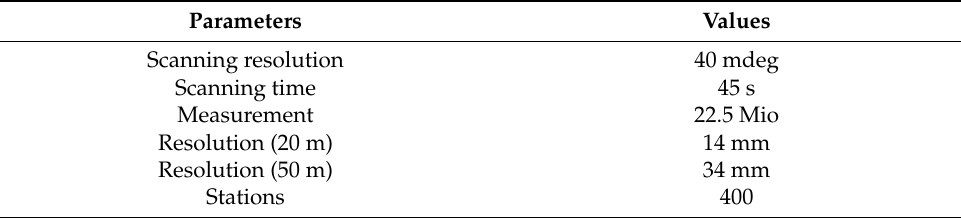
Figure 3. The sample plot and selected tree point cloud. Table 1. RIEGL VZ-400i scanning mode